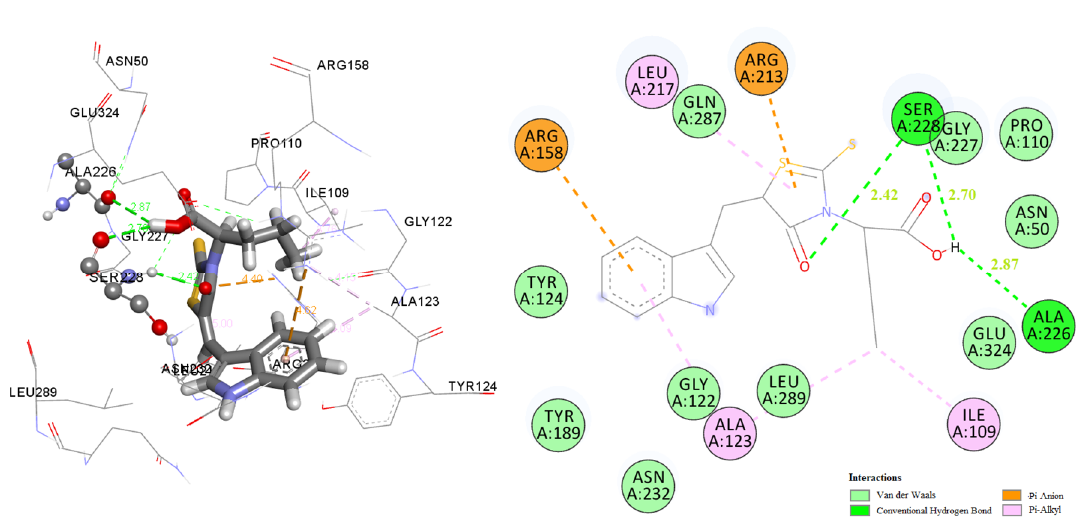
Table 5. Molecular docking binding affinities for antifungal targets.